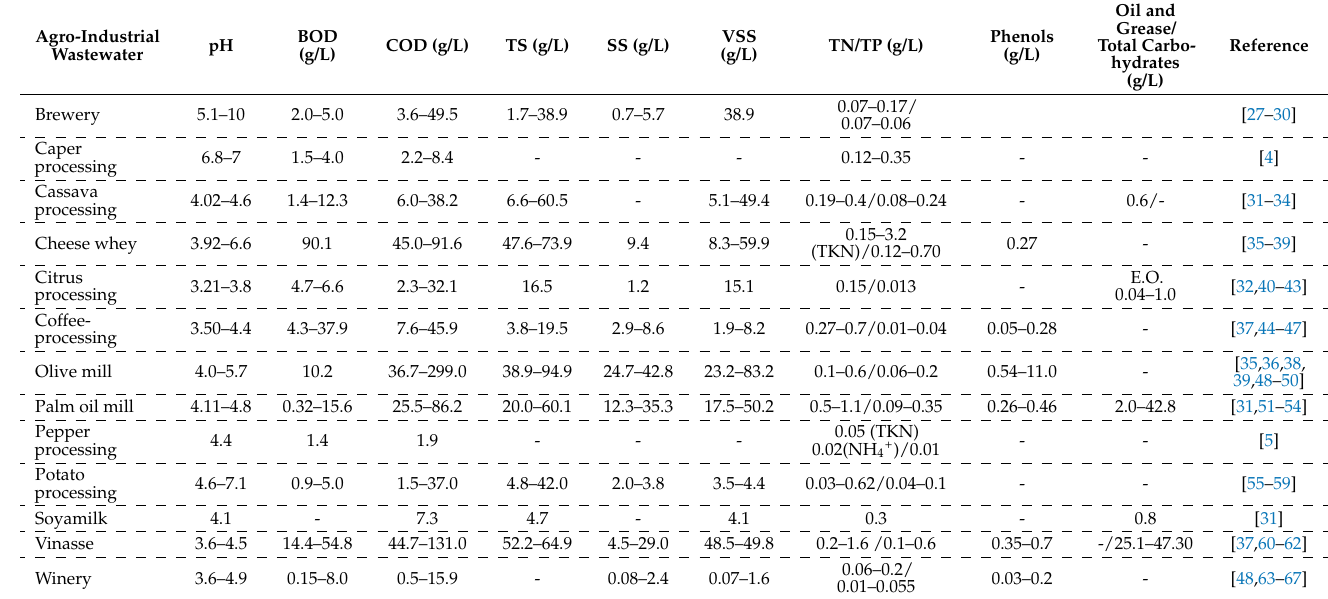
Table 1. Physicochemical composition of the key agro-industrial effluents treated in aerobic wastewa- ter treatment